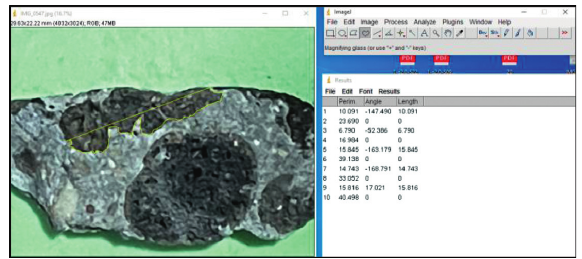
Figure 5: Roughness measurement by ImageJ software on the image of optical microscopy (scale: 29 × 22mm).